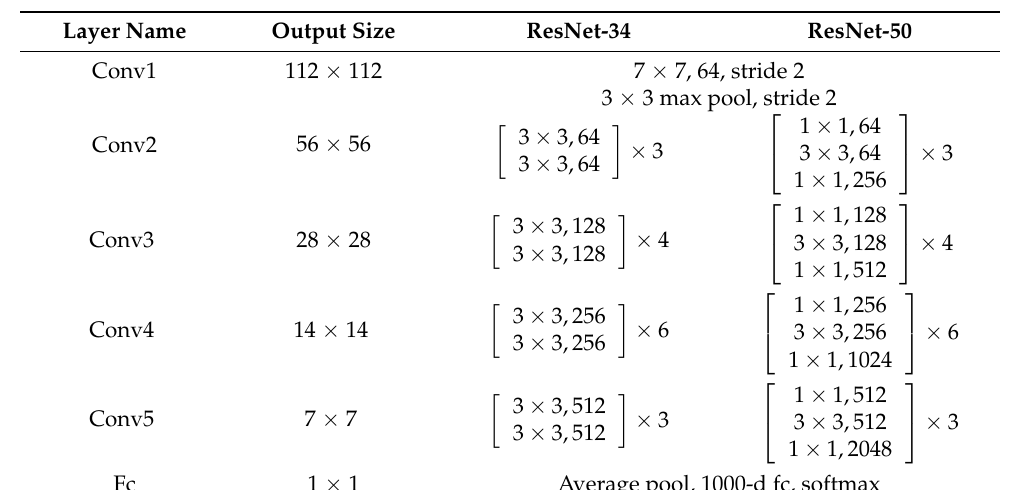
Table 1. ResNet network structure diagram of different depths.